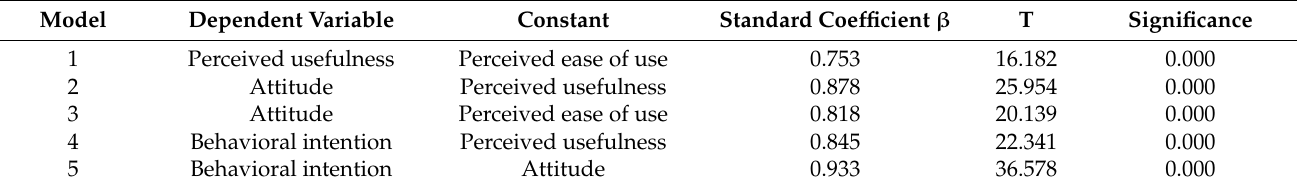
Table 13. Verification of each